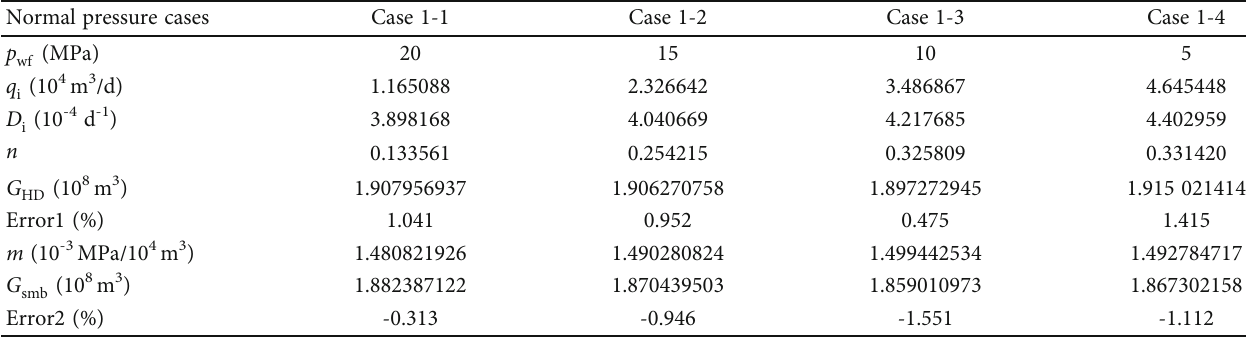
(a) The analysis results of the decline parameter method for numerical cases with normal pressure Normal pressure cases